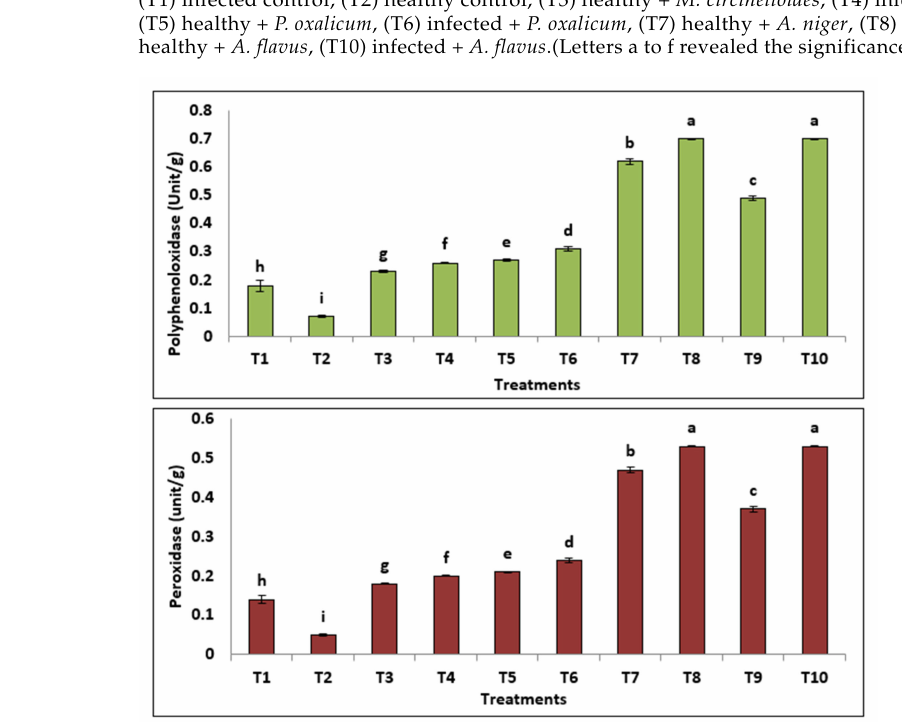
Figure 6. Oxidative enzymes indicators of tomato plant treated with PGPF. (T1) infected control (T2), healthy control, (T3) healthy + M. circinelloides , (T4) infected + M. circinelloides , (T5) healthy + P. oxalicum , (T6) infected + P. oxalicum , (T7) healthy + A. niger , (T8) infected + A. niger , (T9) healthy + A. flavus , (T10) infected + A. flavus